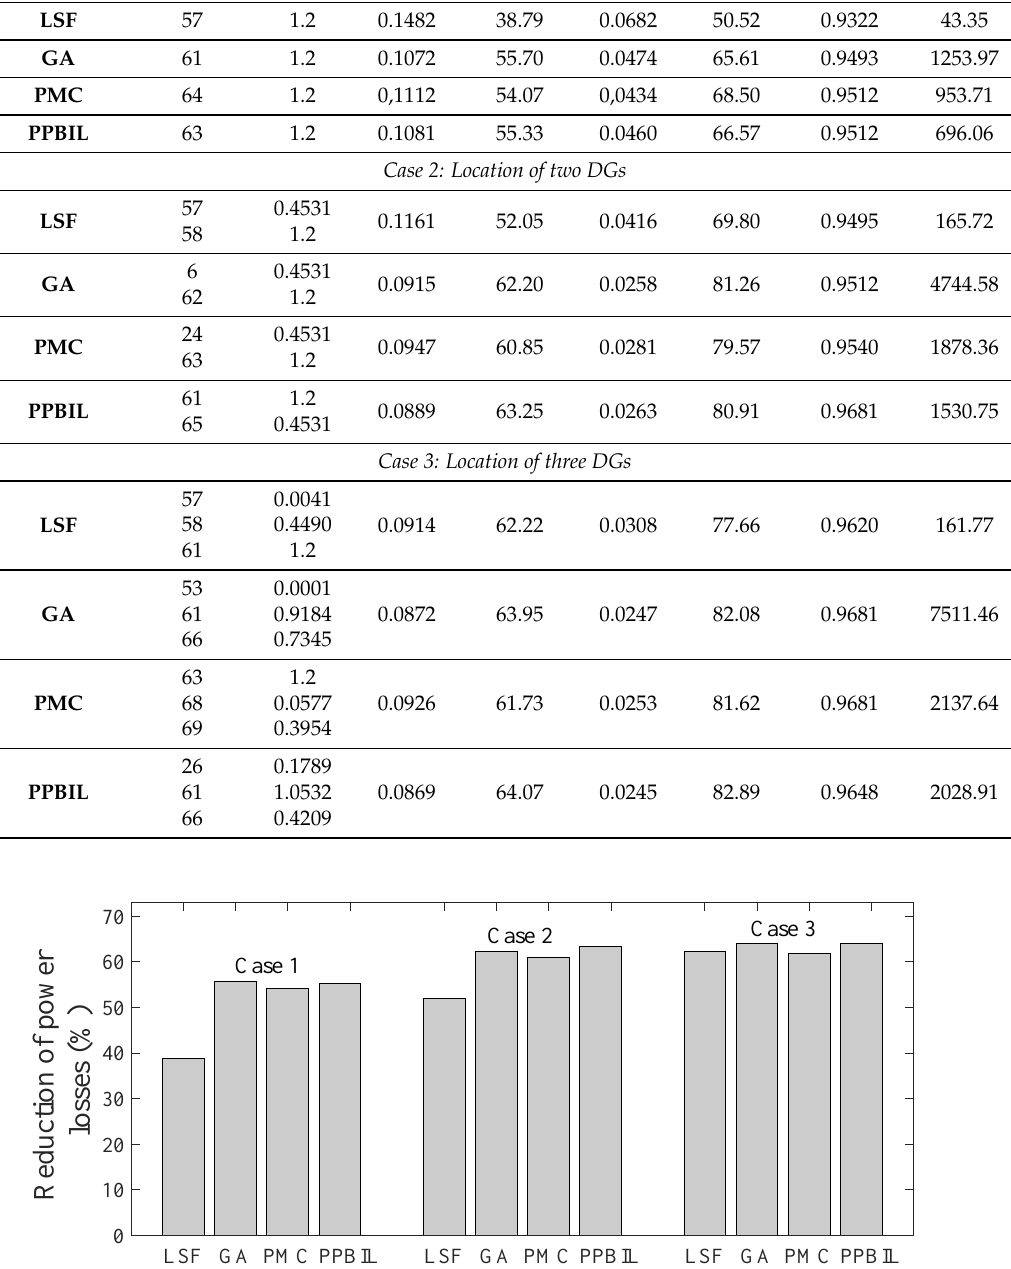
Figure 16. Reduction of power losses in the test system with 69